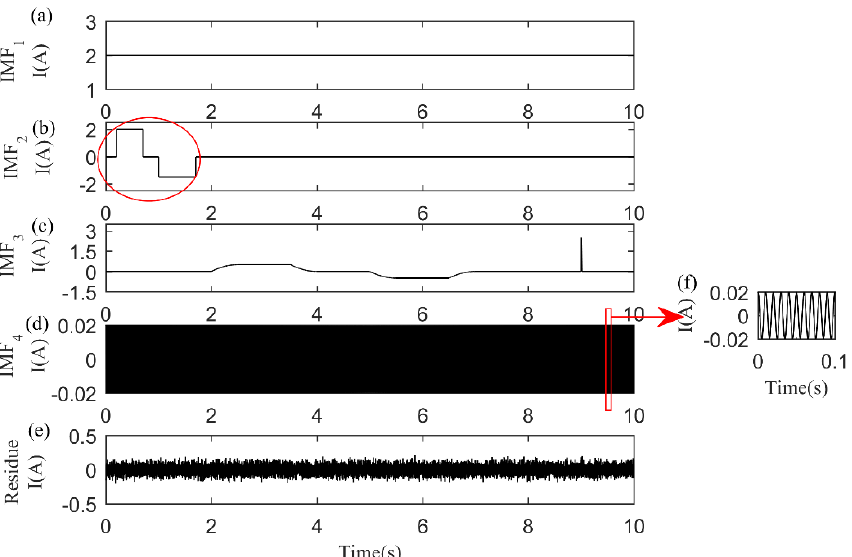
Figure 9. Simulation signal decomposition diagram of MBMD. ( a ) DC signal; ( b ) Wideband signal; ( c ) Narrowband signal; ( d ) Harmonic signal; ( e ) Noise signal; ( f ) A 0.1 s signal extract from ( d ). Table 1. Evaluation parameters of the three algorithms (SNR 25).